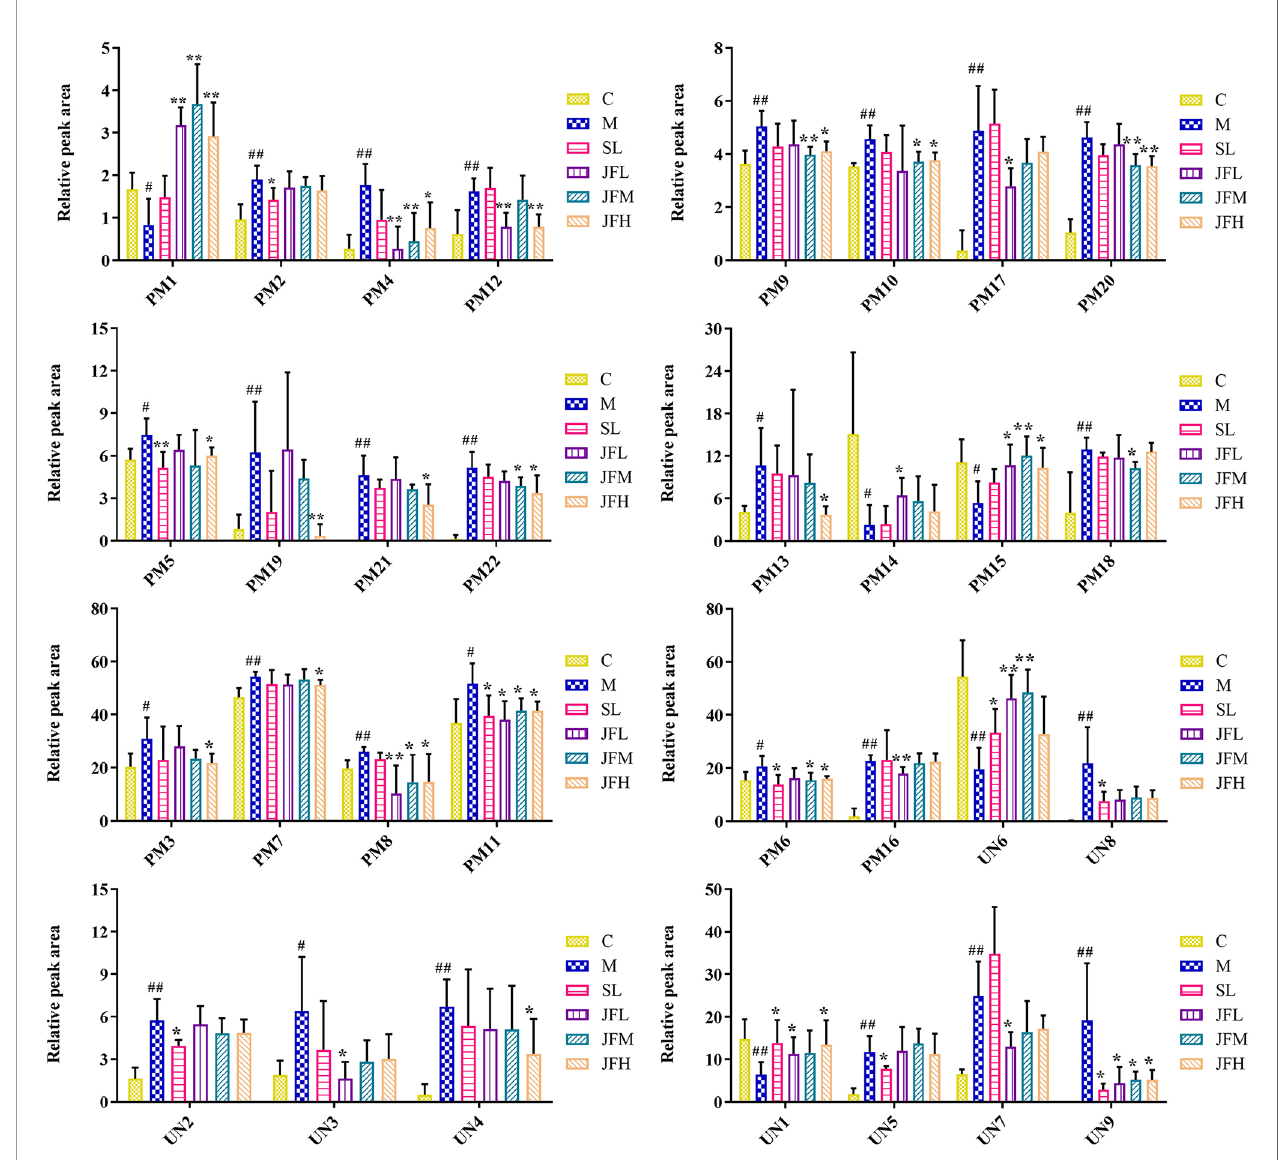
FIGURE 4 | Changes in the relative intensity of target metabolite of plasma and urine identi fi ed by UHPLC-QTOF/MS. (C) control group; (M) model group; (SL) positive group; (JFL) low dose group of JF extract; (JFM) medium dose group of JF extract; (JFH) high dose group of JF extract. Data are expressed as means ± SD, n = 6. # P < 0.05, ## P < 0.01: models vs control; *P < 0.05, **P < 0.01: treatment vs